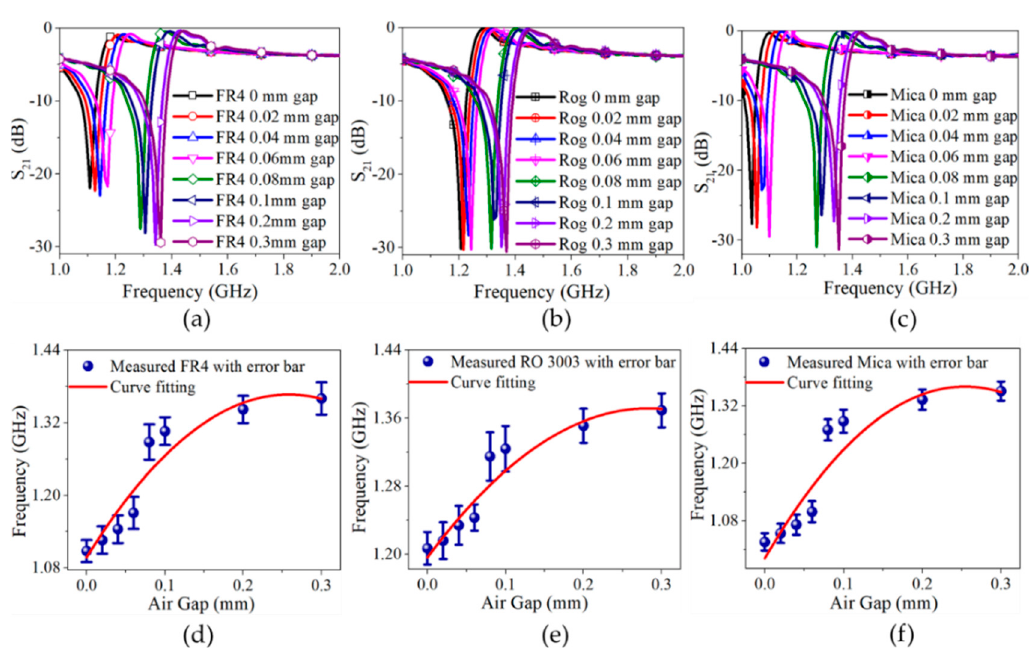
Figure 7. |S 21 |measured analysis of different permittivity MUTs loaded on the high e-field centralized IDC structure with varying air gaps ranging from 0.01–0.3 mm; ( a ) FR4 MUT; ( b ) rogers RO3003 (Rog) MUT; ( c ) mica MUT curve fitting technique analysis with error bars for the triplicate measurement of testing MUTs with varying air gap scenario; ( d ) FR4; ( e ) rogers RO3003; and ( f ) mica.